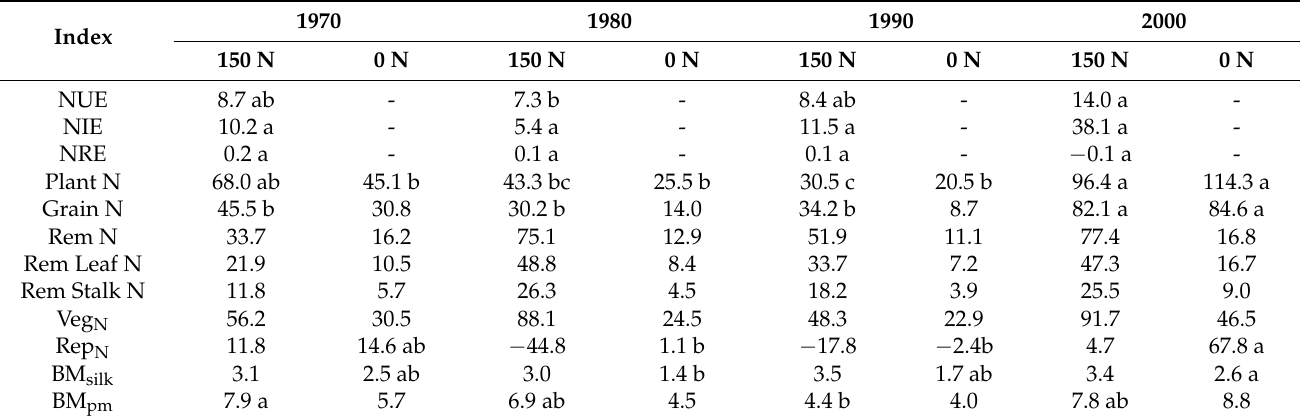
Table 4. The mean absolute heterosis value of NUE and related parameters of hybrids.